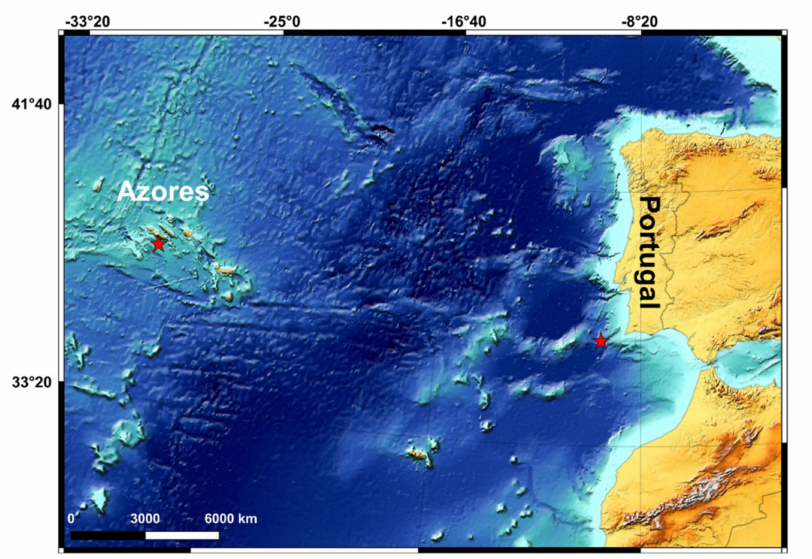
Figure 1. Locations of the OBS (red stars) that recorded fin whale notes used in this